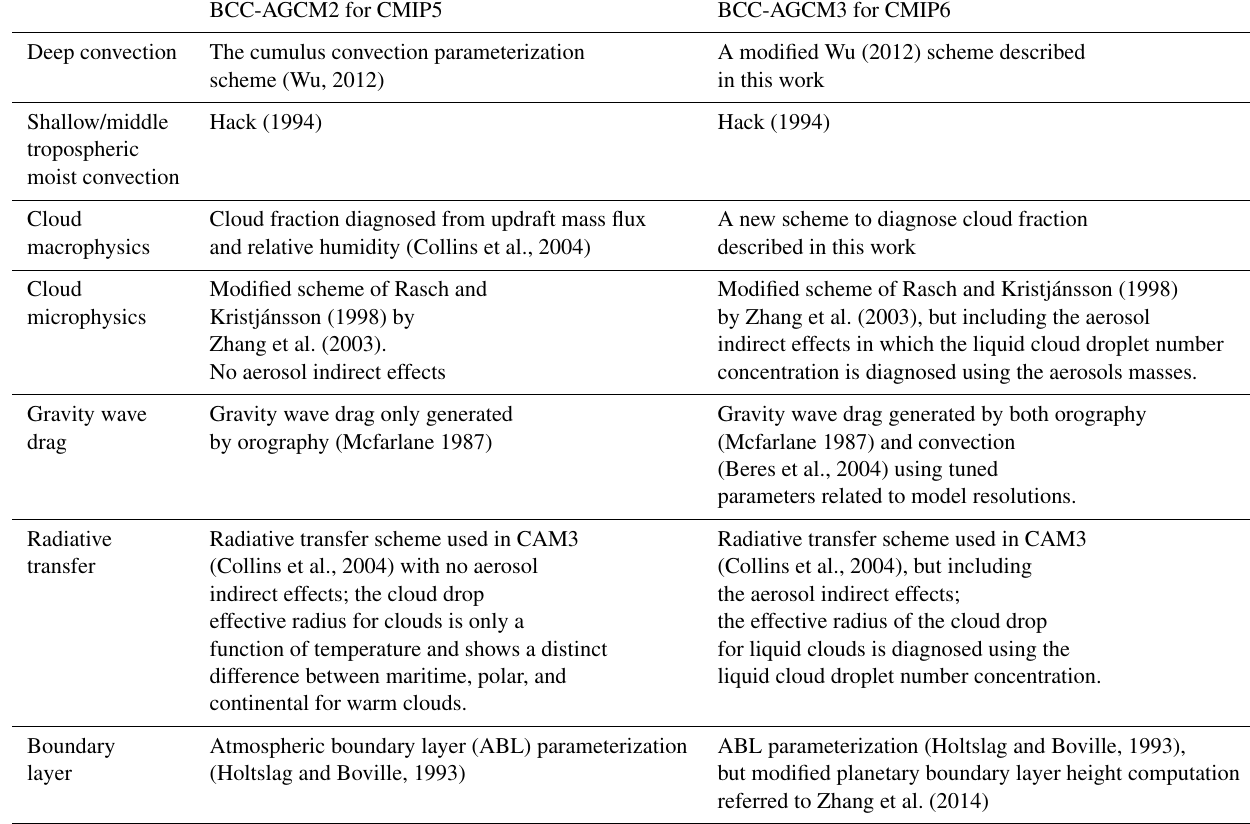
Table 2. Main physics schemes in the atmospheric components (BCC-AGCM) of the BCC-CSM versions for CMIP5 and CMIP6. BCC-AGCM2 for